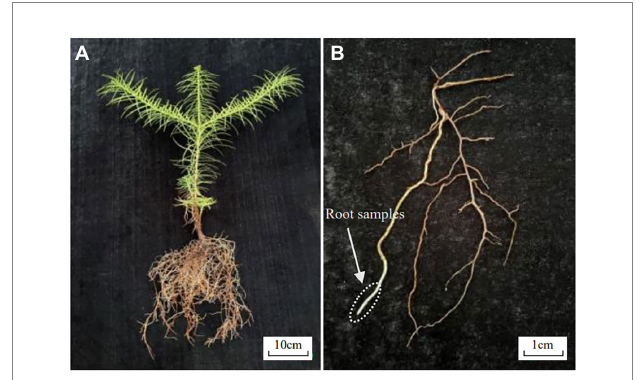
FIGURE 1 (A) Whole plant phenotype and (B) root materials of Chinese fir